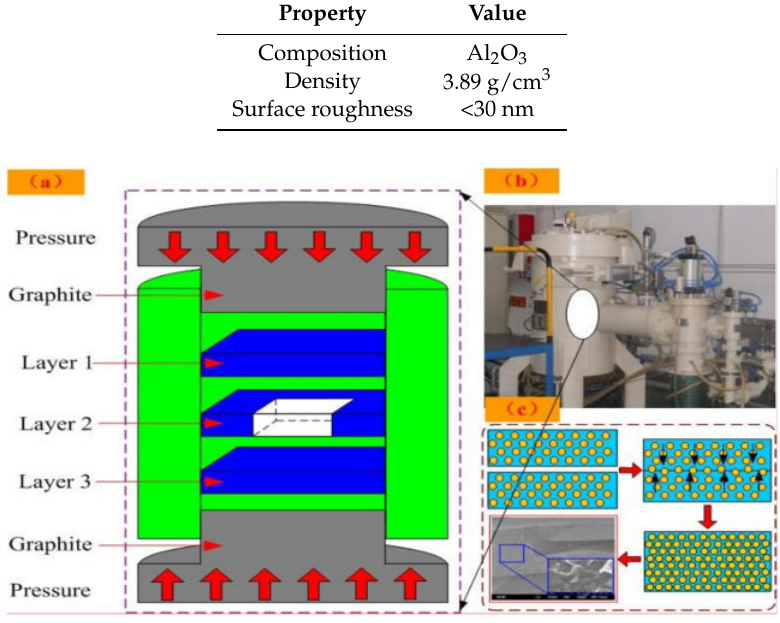
Figure 2. ( a ) Fabrication process for the sensitive cavity based on alumina ceramic; ( b ) Hot press furnace; ( c ) Special connecting process of the alumina